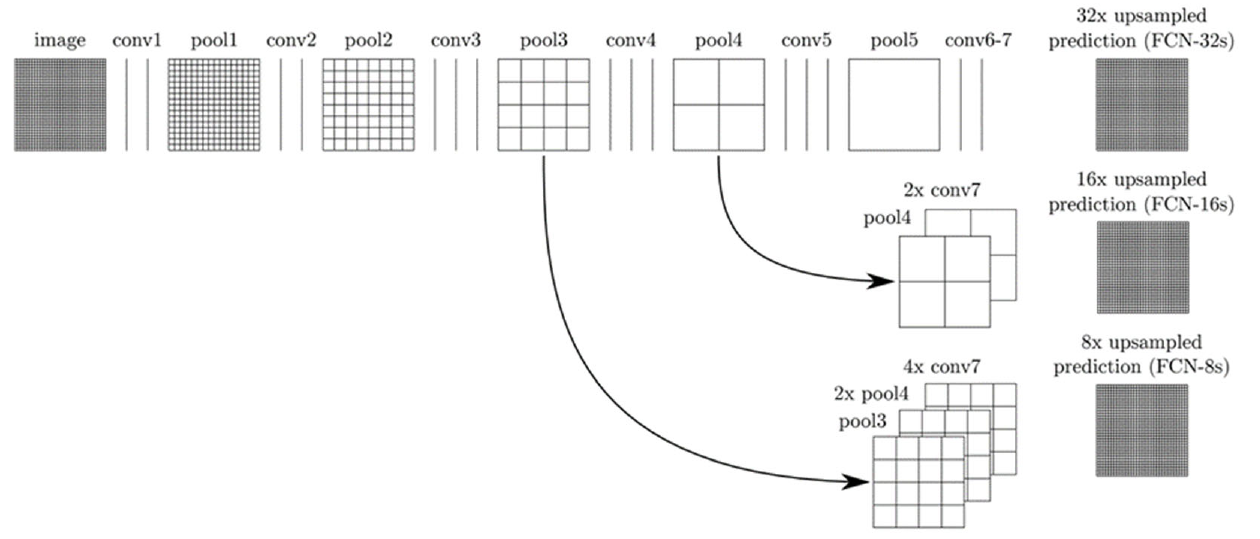
Figure 2. The structure of FCNLayer architecture [46].